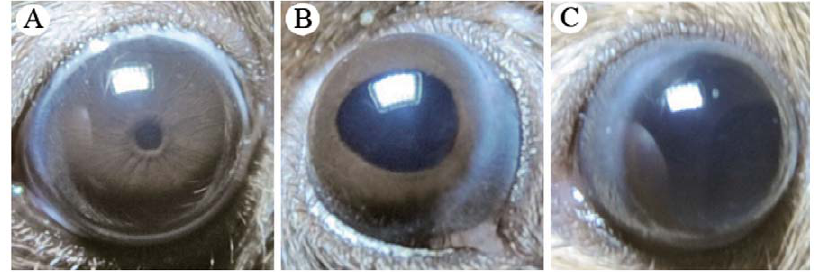
Figure 1. Pupil phenotype of Dp1 mice. (A) Wild-type mouse with normal pupil. (B) Dp1 mouse with a partially dilated pupil phenotype (heterozygous mouse). (C) Dp1 mouse with a severely dilated pupil phenotype (homozygous mouse).